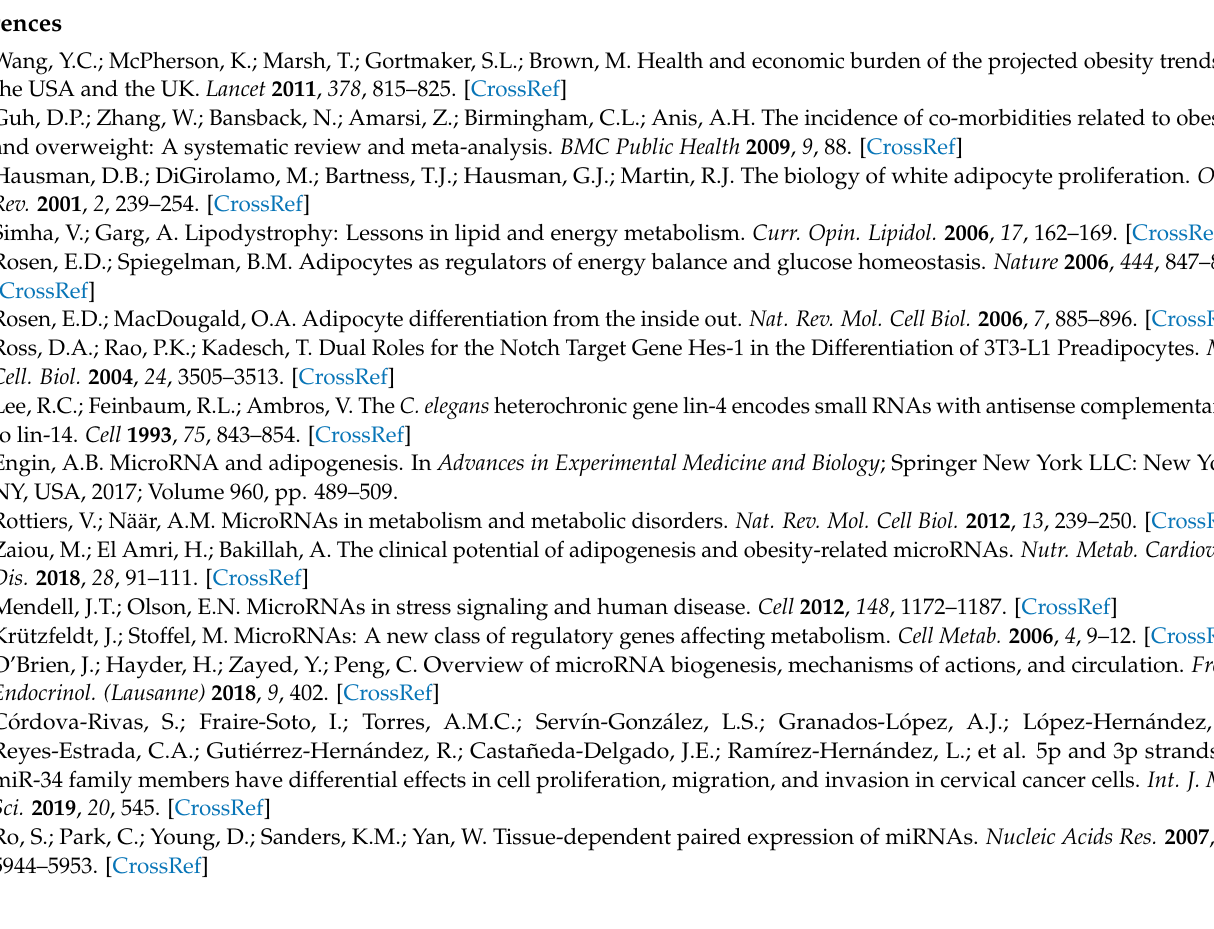
miR-27a-3p in hMADS cells, Figure S9: Knock-down of PPAR γ impairs adipogenesis of SGBS cells, Figure S10: Adipogenic differentiation is enhanced by miR-27a-3p inhibitor in SGBS cells, Figure S11: Lower dose of miR-27a-3p can decrease adipogenic differentiation in SGBS cells, Figure S12: miR-27a-3p and -5p expression is increased in gonadal WAT after 8 weeks of high- fat diet (HFD), Table S1: Significant results of the EnrichR analysis for